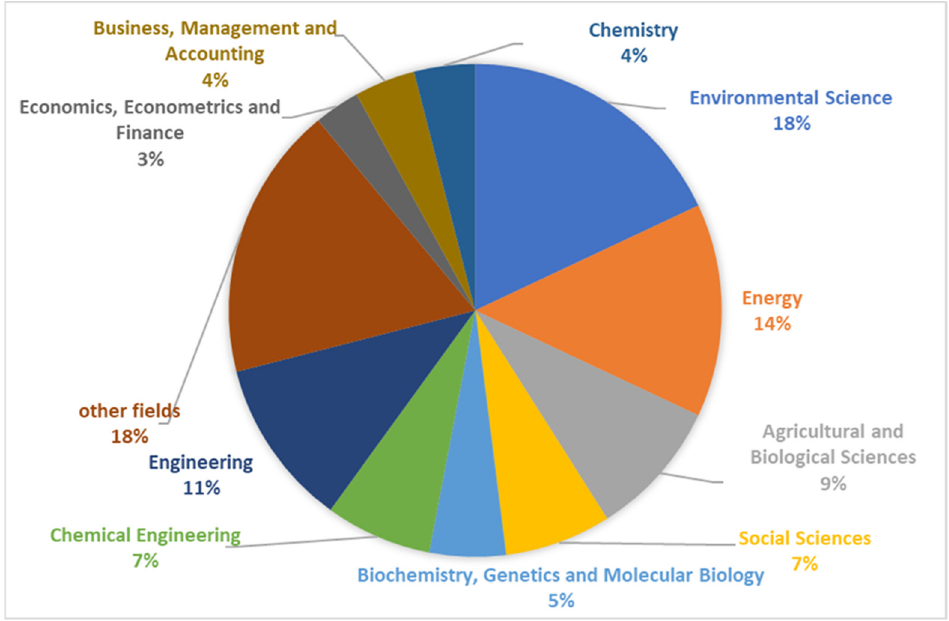
Figure 2. The main sectors with publications on bioeconomy.